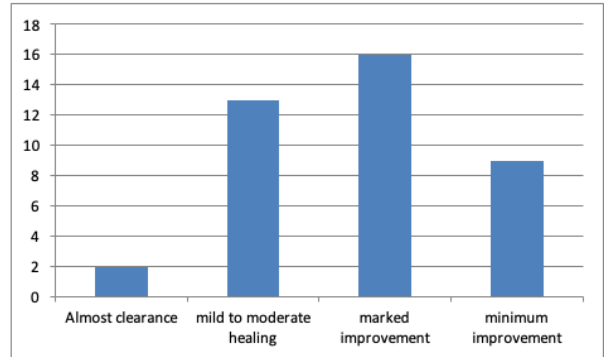
Figure 1: Grades of improvement after 1st laser session.